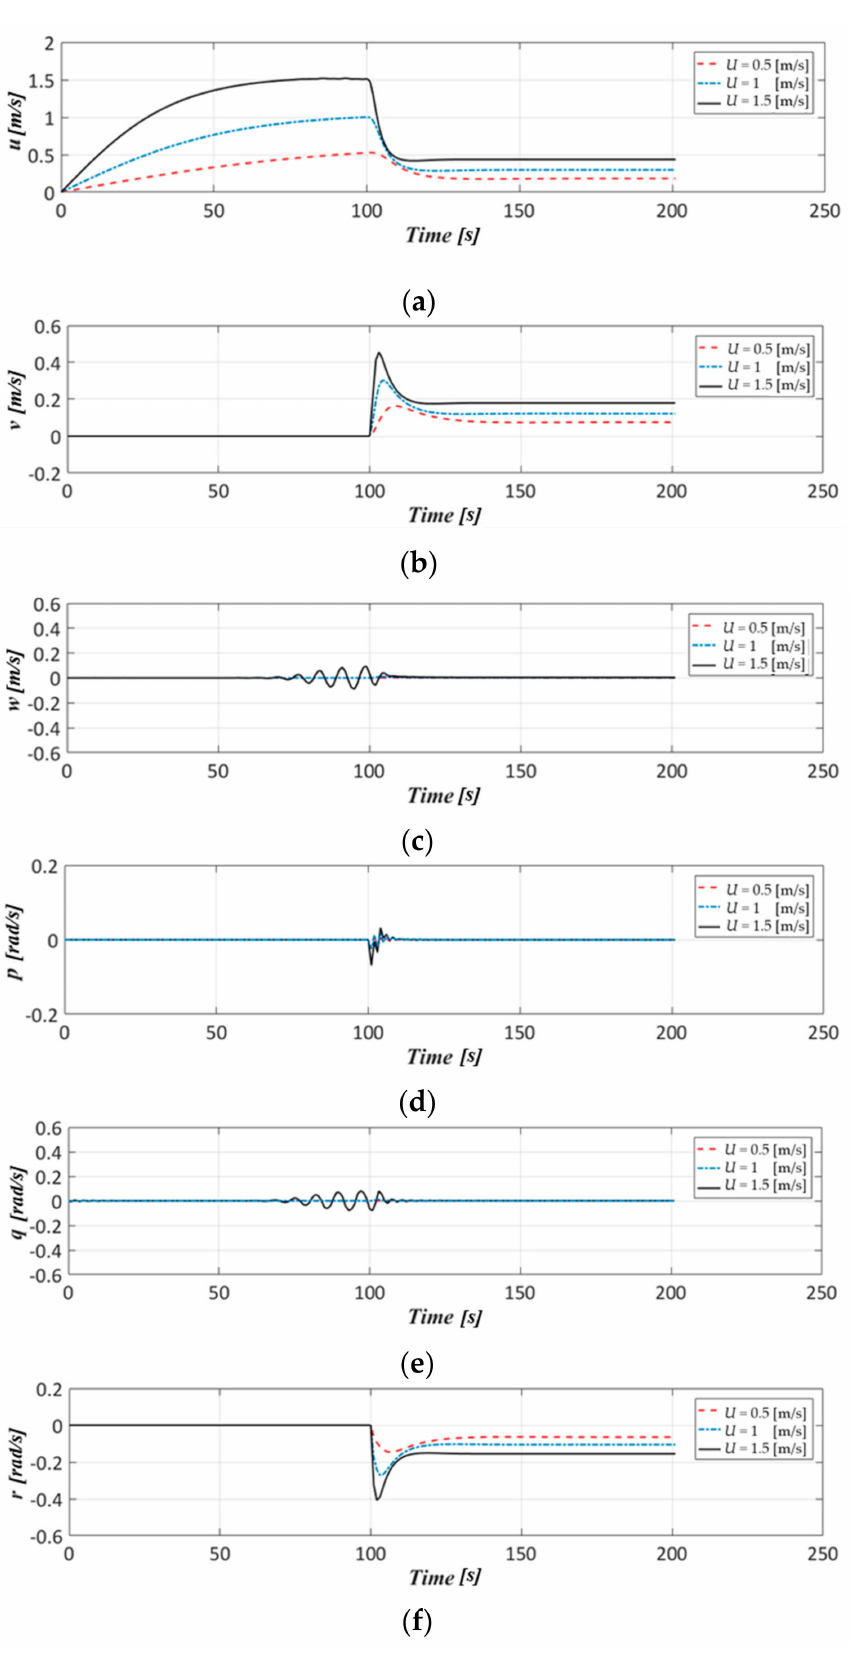
Figure 13. Time series of 6-DOF velocity components during the turning circle test at different sailing speeds. ( a ) Surge rate: u [m/s], ( b ) sway rate: v [m/s], ( c ) heave rate: w [m/s], ( d ) roll rate: p [rad/s], ( e ) pitch rate: q [rad/s], and ( f ) yaw rate: r